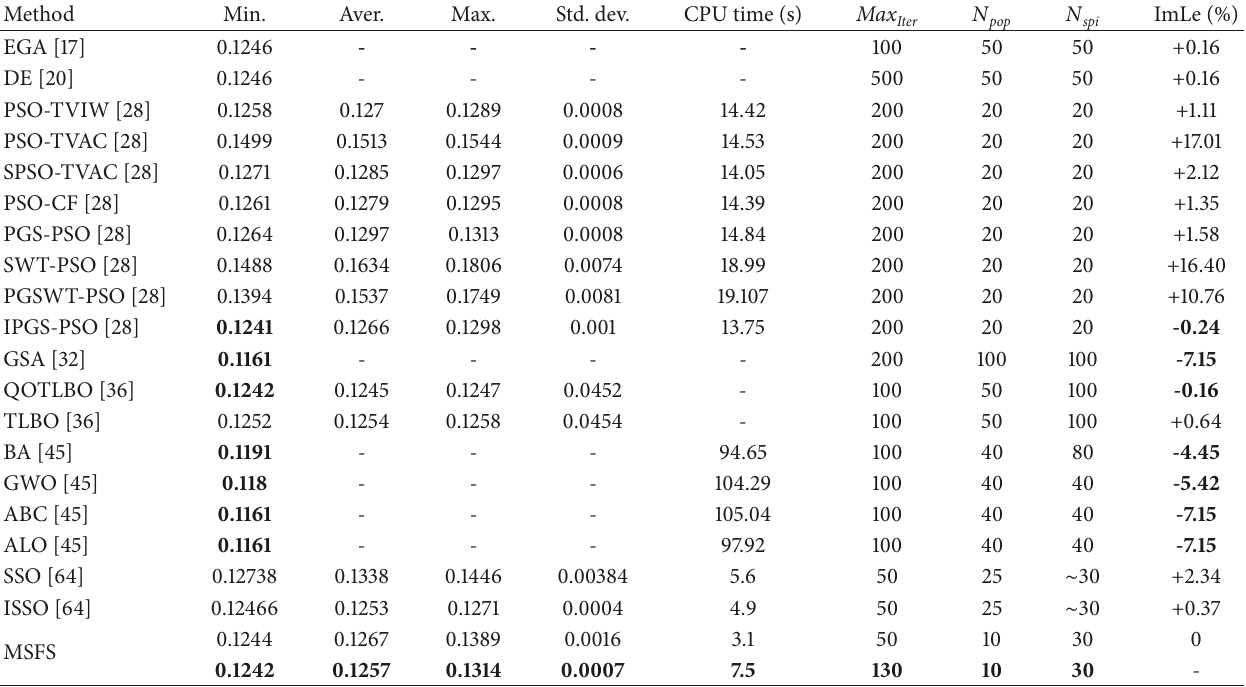
Table 7: Comparison of results obtained from IEEE 30-bus system with voltage stabilization index optimization. Method